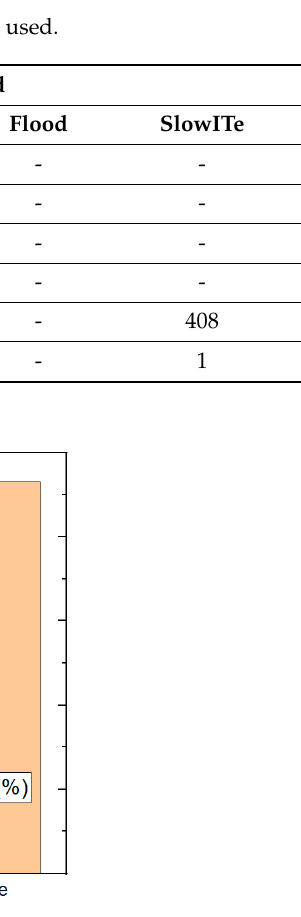
Figure 16. Accuracy when the message type is not used. Table 7. Confusion matrix when the message type is not used.